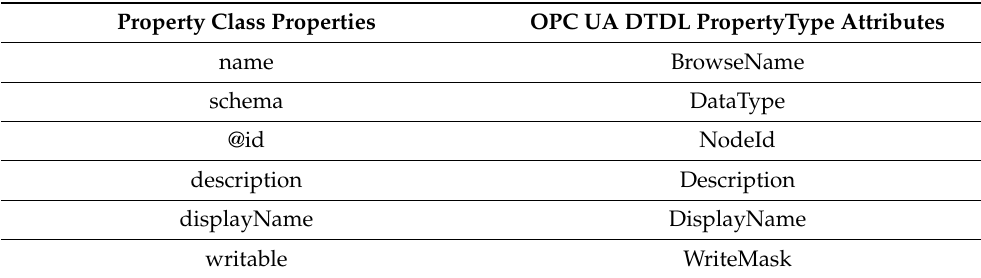
Table 8. Mapping of properties of the Property class into OPC UA DTDL PropertyType attributes.